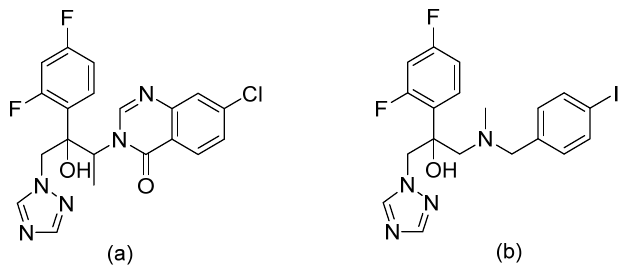
Figure 13. The chemical structures of ( a ) albaconazole and ( b ) iodiconazole.